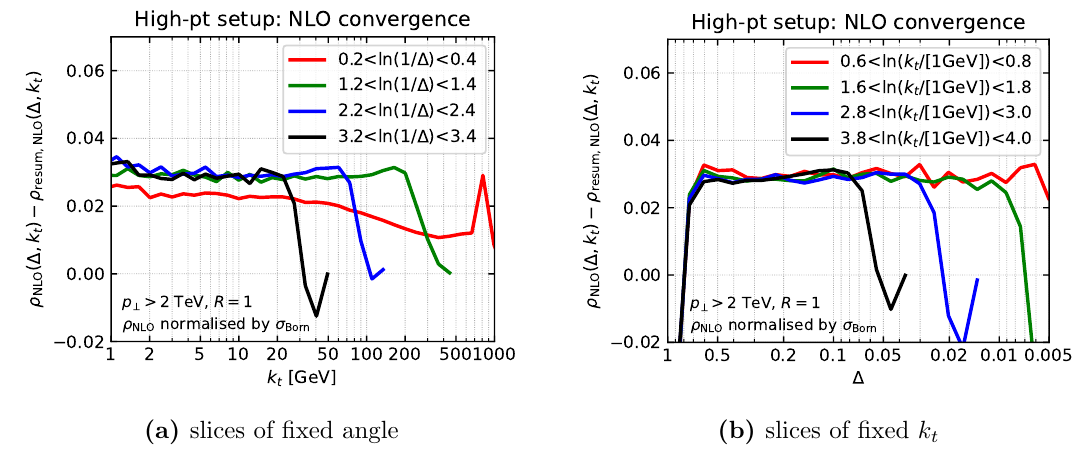
Figure 15. Di(cid:11)erences between the exact NLO results and the NLO expansion of our resummation for di(cid:11)erent slices of the Lund plane. Control of single logarithmic terms in our resummation implies that these di(cid:11)erences should tend to a constant both for small k t and for small (cid:1), as observed, except as concerns subleading- N c terms in the small- k t , large (cid:1) region. The exact NLO results are normalised here to the Born-level jet cross-section.